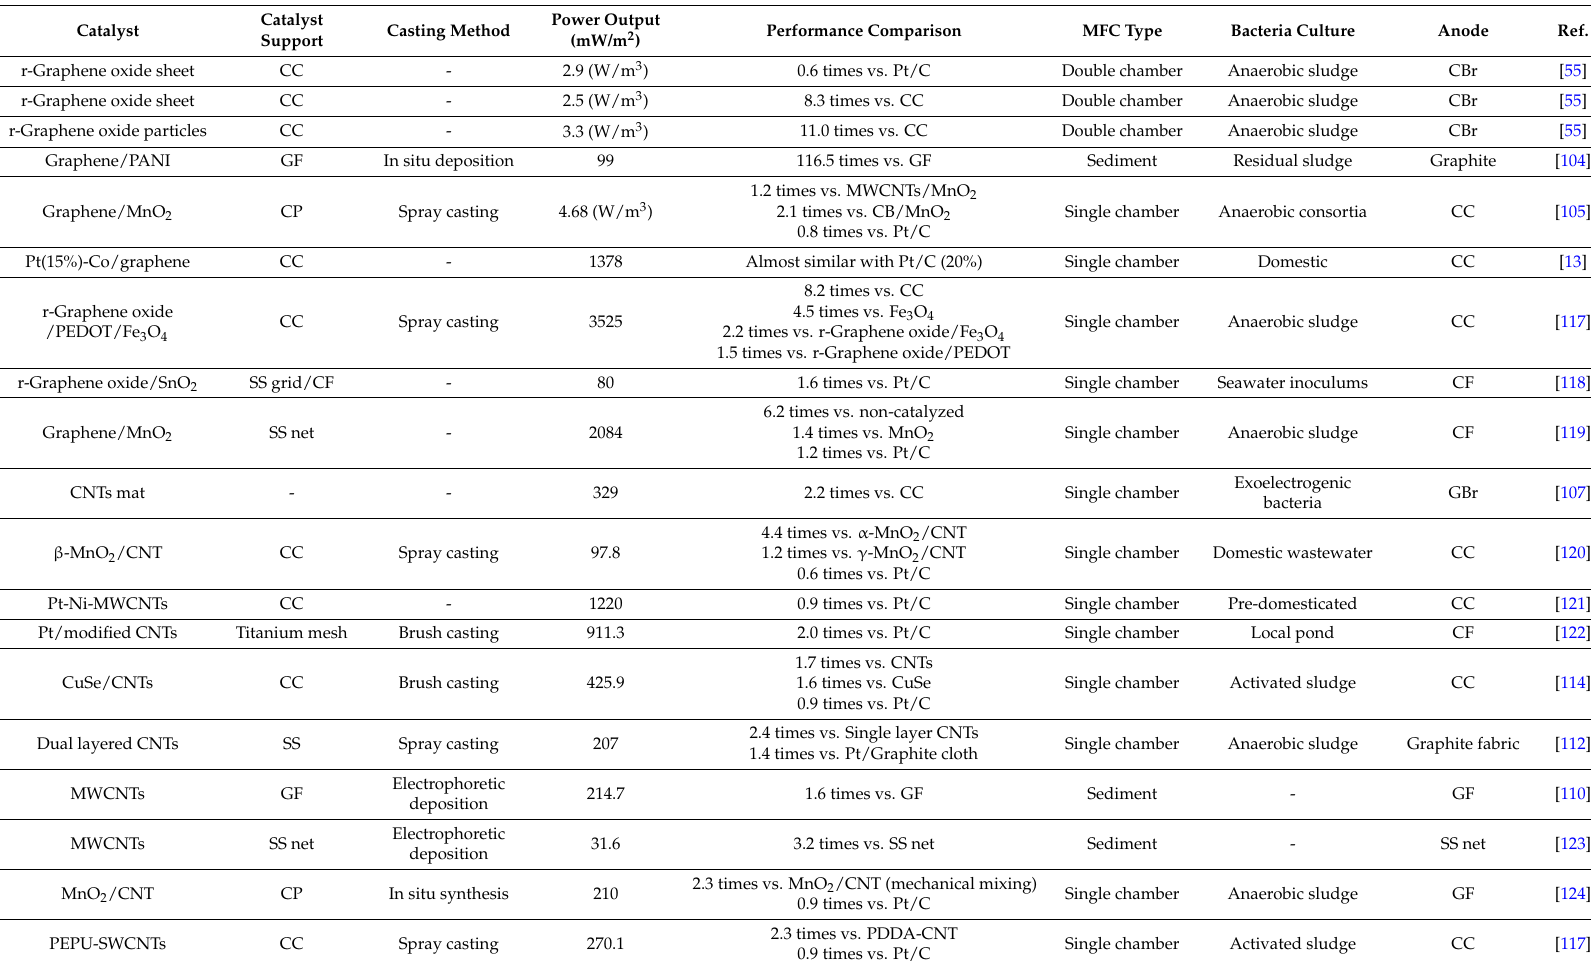
Table 5. Summary of the performances of different MFCs operated using graphene and CNT-based cathode